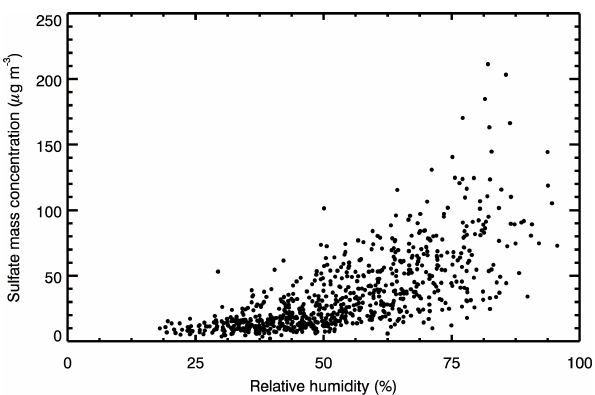
Figure 5. Scatter plot of the observed PM 2 . 5 with iron mass concen- trations at IEECAS site in Xi’an during the wintertime from 2003 to